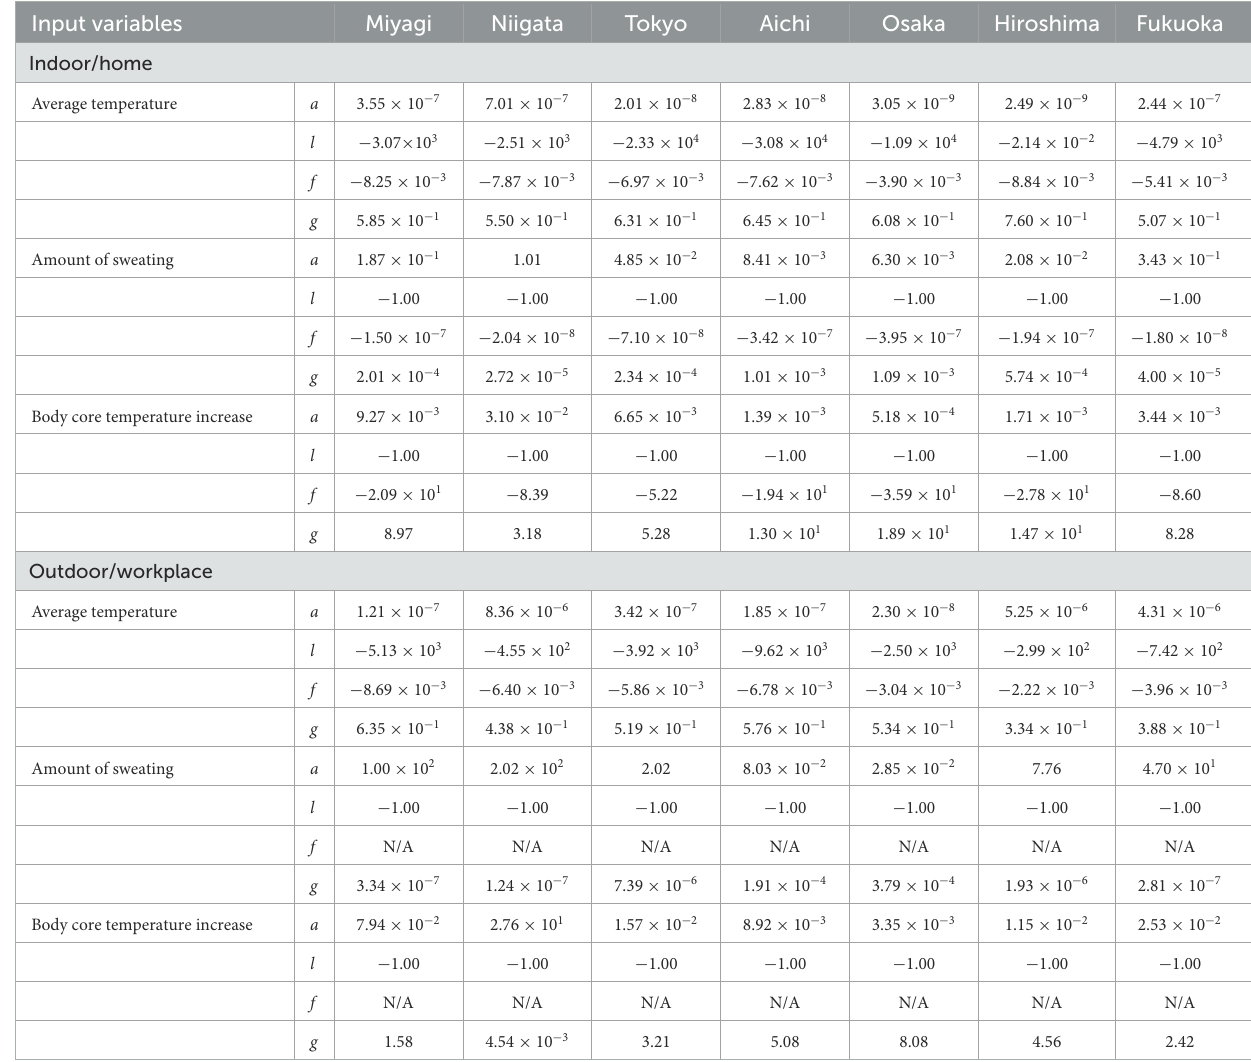
TABLE 3 The parameters in Equations (2–4) for estimating patients transported from indoor and outdoor locations for average ambient temperature, amount of sweating, and body core temperature increase. Input